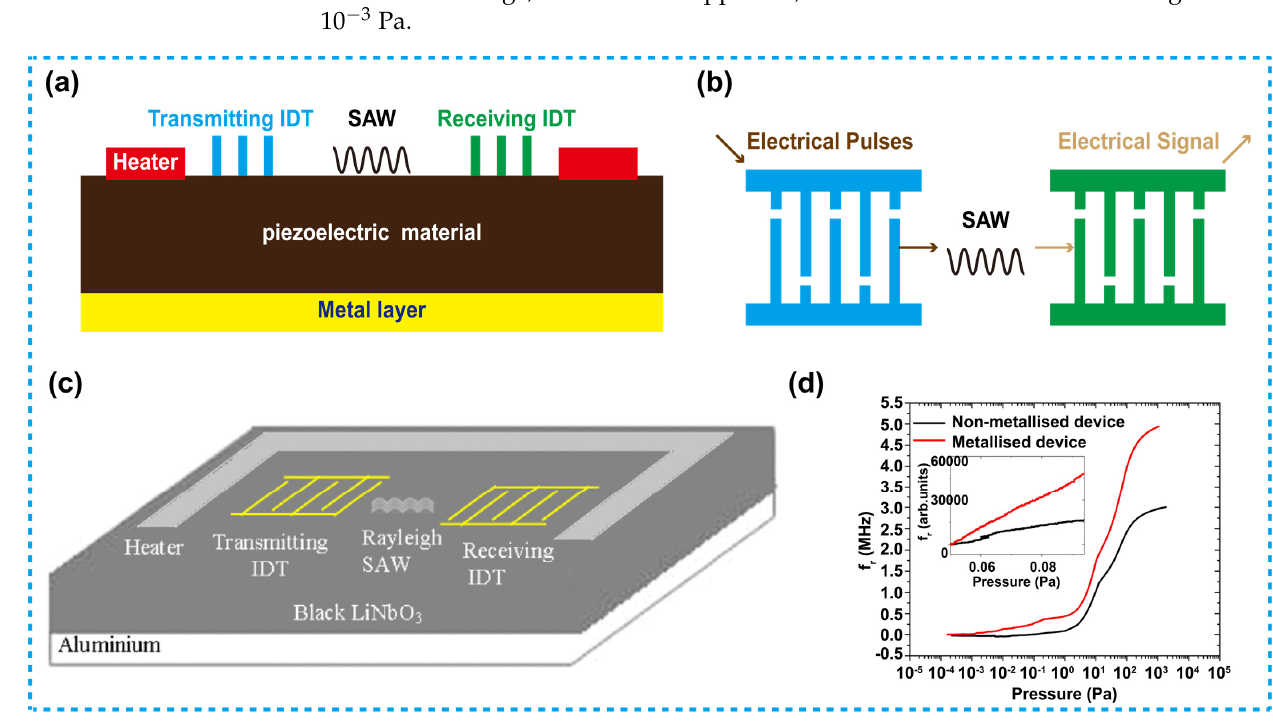
Figure 7. SAW-based Pirani sensors. ( a ) Schematic of a SAW Pirani sensor. ( b ) Structure of the interdigital transducers. ( c ) Schematic diagram of a metallized SAW Pirani sensor [98]. ( d ) Frequency response as a function of pressure observed for the nonmetallized and metallized devices, the sensitivity of the metallized device is higher than that of the nonmetallized